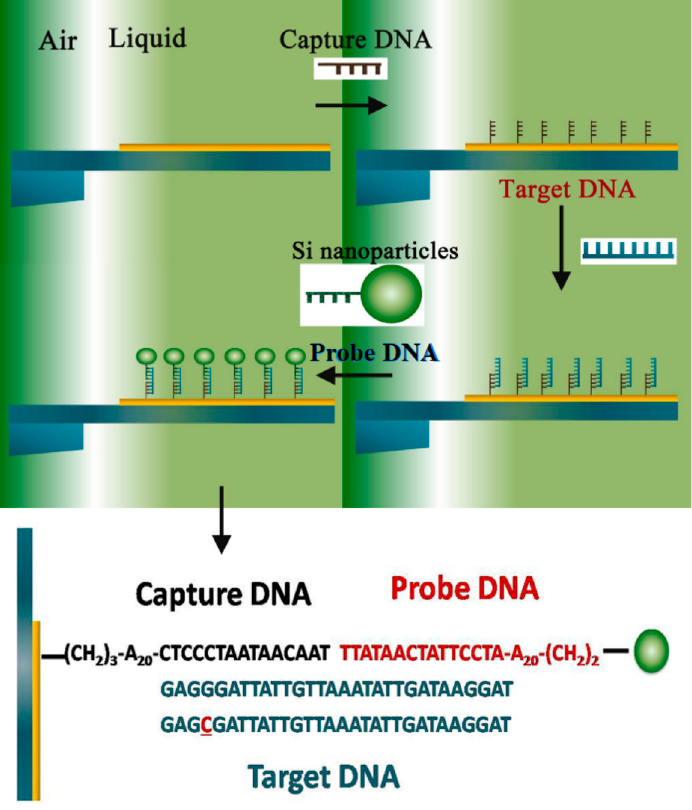
Figure 2. The DNA detection protocol of a spin microcantilever based on in situ hybridization [57].